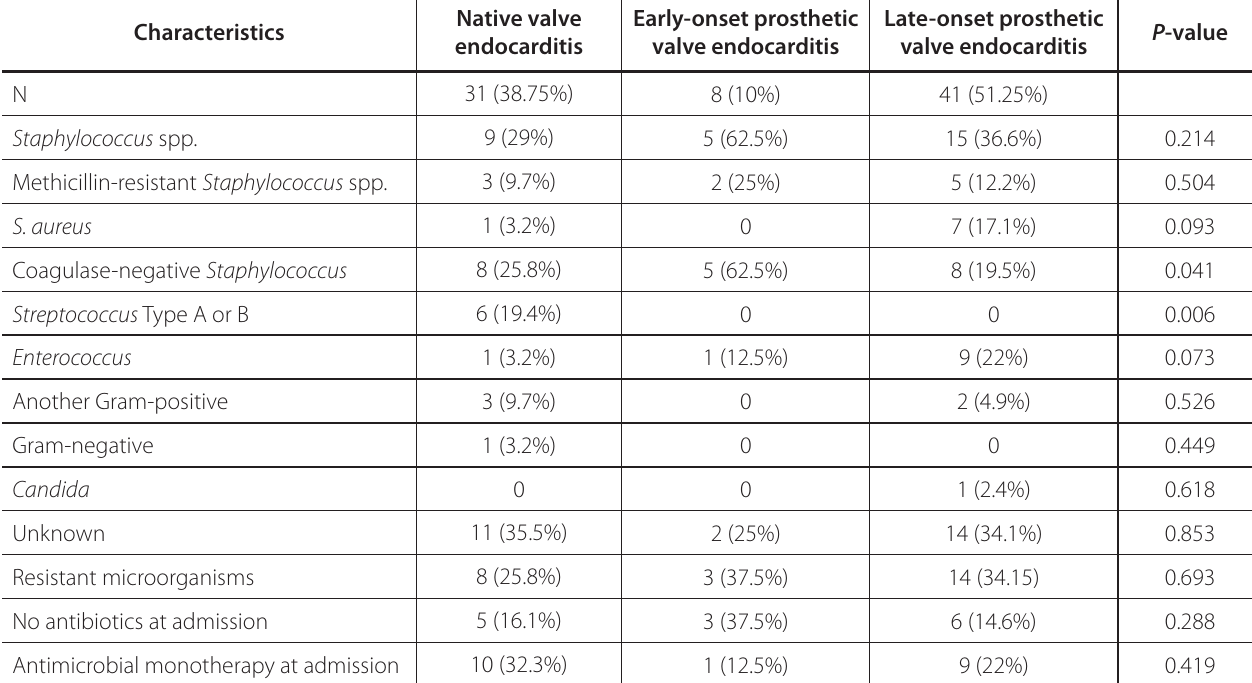
Table 3 . Microbiological